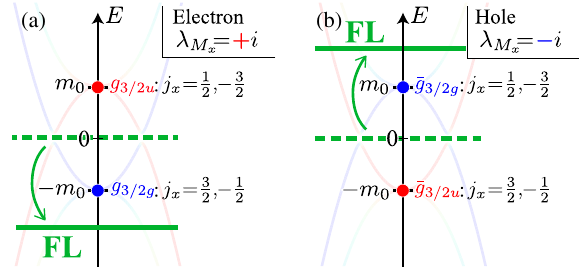
FIG. 6. Level structures and their angular momentum in the λ i sector at the Γ point. (a) and (b) indicate electron and M x τ z ¼ hole sectors, respectively.